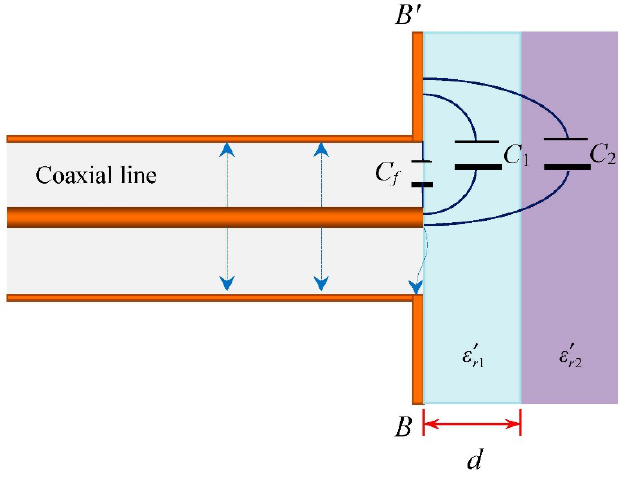
Figure 6. Equivalent parallel capacitance model.